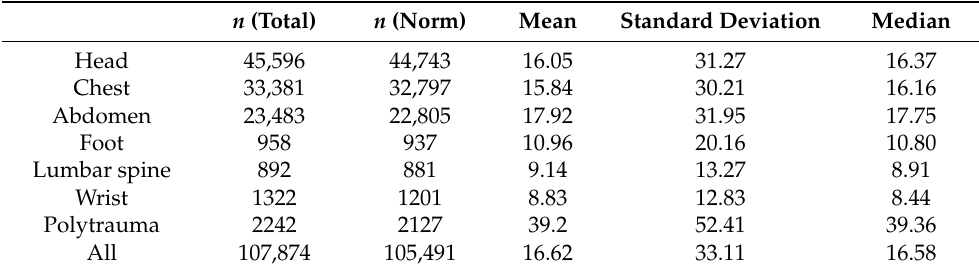
Table 1. n (total): all available timestamps, n (norm): cases after outlier reduction which follows a normal